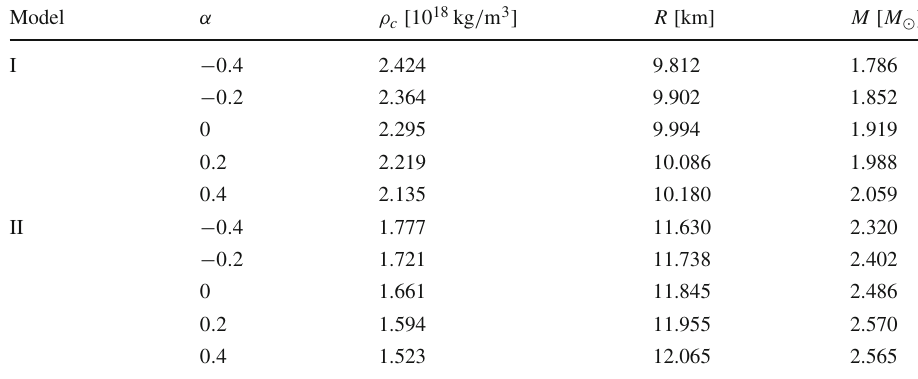
Fig. 1 Left panel: Mass-radius diagrams for dark energy stars with Chaplygin-like EoS (28) and isotropic pressure ( σ = 0) for several val- ues of the positive parameters A and B . Here the constant B is given in μ = 10 − 20 m − 4 units. The gray horizontal stripe at 2 . 0 M (cid:10) stands for the two massive NS pulsars J1614-2230 [85] and J0348+0432 [86]. Yellow and blue regions represent the observational measurements of the masses of the highly massive NS pulsars J0740+6620 [87] and J2215+5135 [94], respectively. The filled pink band stands for the lower mass of the compact object detected by the GW190814 event [91],